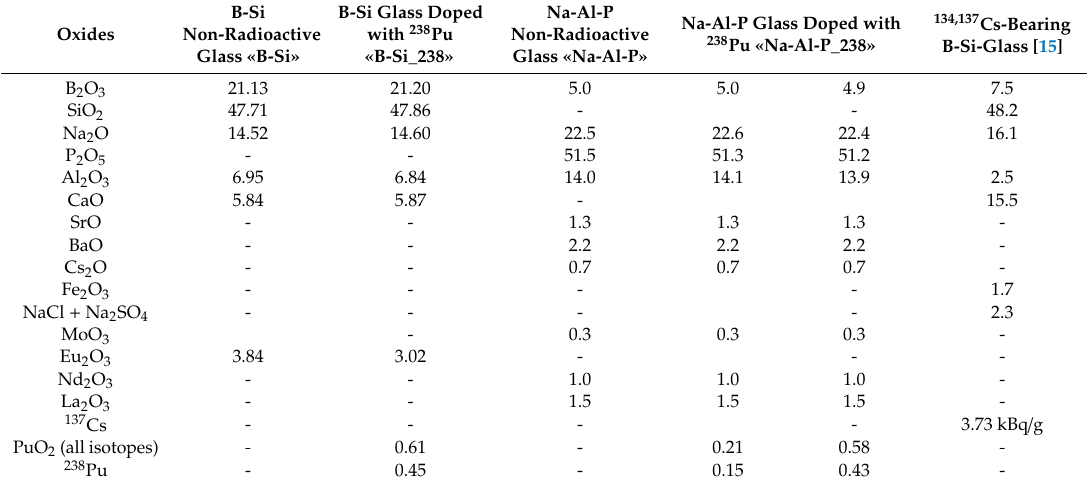
Table 1. Compositions of non-radioactive and Pu-doped glasses obtained, wt.%. Uncertainty for